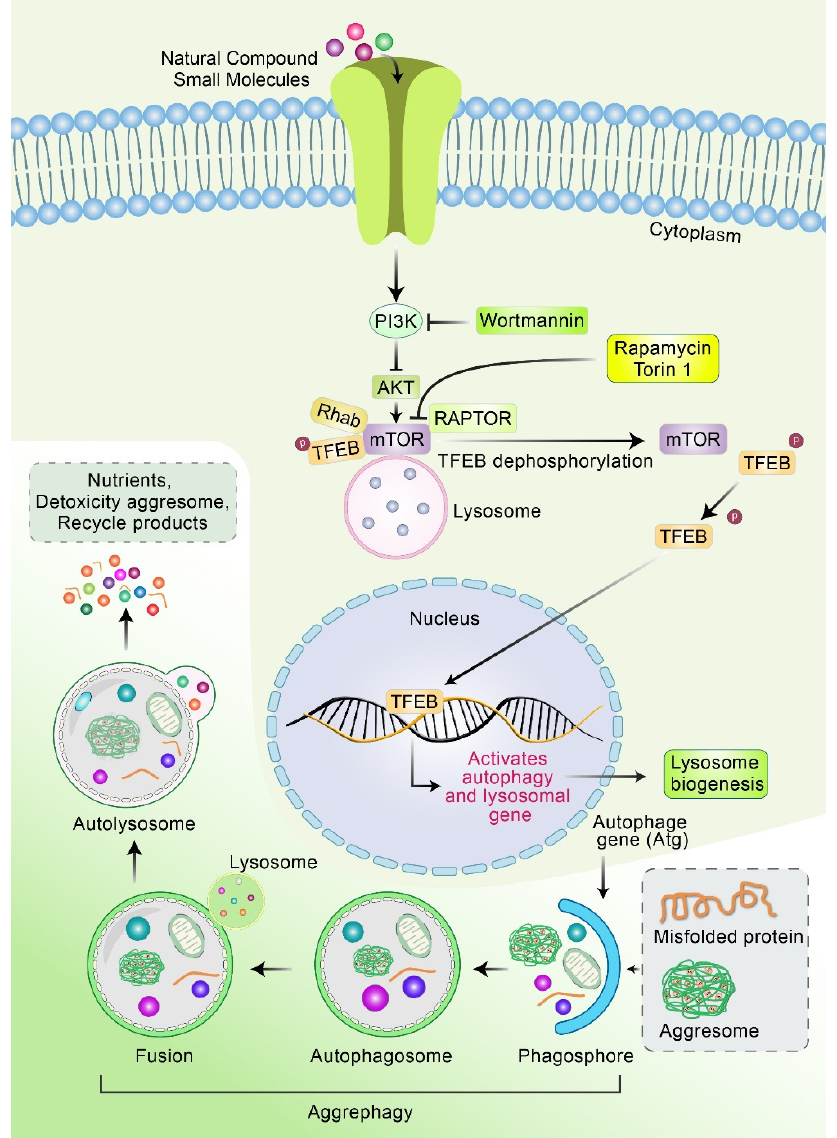
Figure 5. Mechanism of natural compounds or small molecules to activate mTOR and TFEB in autophagy–lysosomal process. Natural compounds or small molecules inactivate AKT and mTOR, which promote the accumulation of TFEB in the cytoplasmic and its nuclear translocation. TFEB in cytoplasm is heavily phosphorylated and interacts with mTOR in the lysosome surface. The inactivation of mTOR activity stimulates the dephosphorylation of TFEB. Subsequently, dephosphorylated TFEB is translocated from cytoplasm to nucleus. In nucleus, TFEB binds to the promoter regions of autophagy- and lysosomal-associated genes and induces gene expression in addition to lysosome biogenesis. The aggresome is bound to the phagophore, resulting in the formation of the autophagosome. Eventually, the autophagosome fused with lysosome degrades aggresomes via aggrephagy